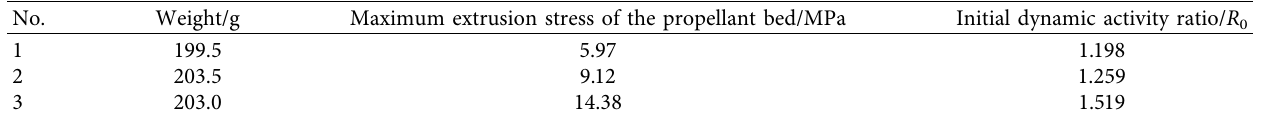
Table 6: Test data of the initial dynamic activity ratio of samples aged for 15